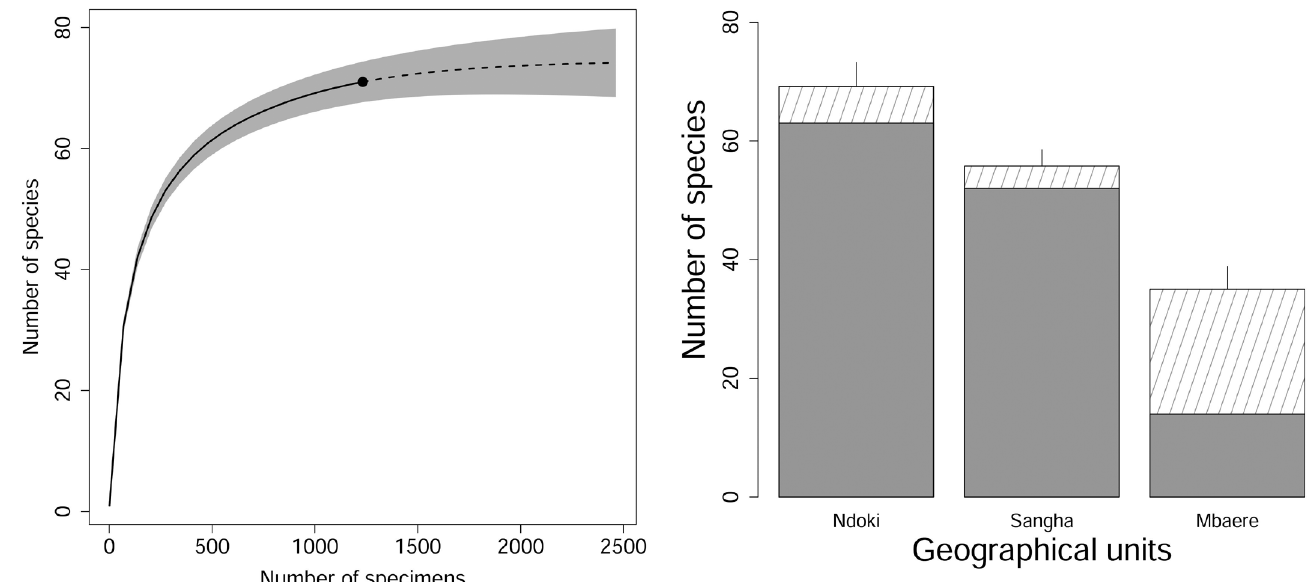
Fig. 10. Species richness in the three zones studied: Ndoki = Dzan- ga-Ndoki National Park zone; Sangha = Dzanga-Sangha Special Reserve zone; Mbaere = Rest of the Sangha-Mbaere Region; grey chart = observed number of species; dashed chart = estimated rich- ness (ACE index) and associated standard deviation.